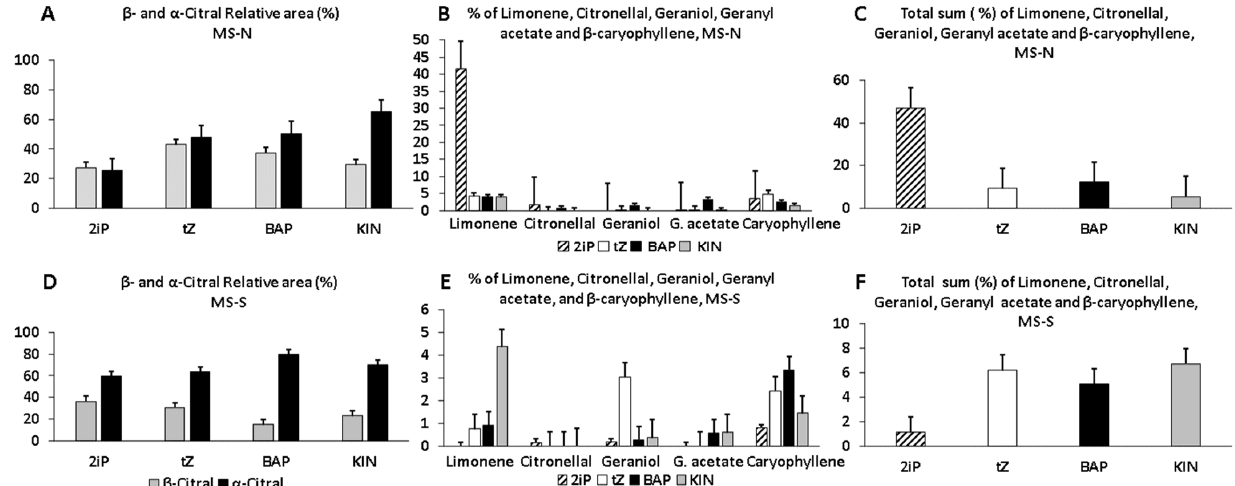
Figure 4. Quantitative analysis of relative abundance (%) of essential oil detected from lyophilized leaf samples of C. citratus grown in pots derived from in vitro shoots treated with 0.5 mg L −1 each CK. ( A , D ) Effect of each CK on the content (%) of the major EO bioactive compounds, β - and α - Citral, in leaves of established plants derived from in vitro shoots grown in MS-N or MS-S. ( B , E ) Effect of the different CKs on the individual content (%) of each minor EO bioactive compound quantified from established plants derived from in vitro shoots grown on MS-N or MS-S. ( C , F ) The sum of the contents (%) of the five minor EO bioactive compounds produced by each CK treatment showed in ( B) and ( E ),